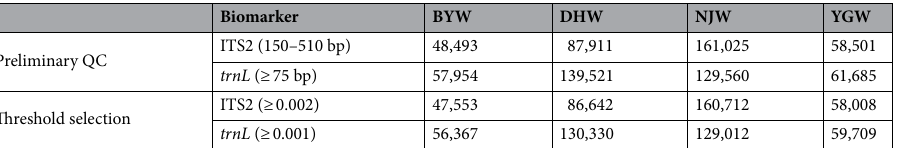
Table 1. The average number of reads of each sample after preliminary quality control and threshold filtration for the four TCM preparations. Note that, QC means quality control, we removed the reads that were below 150 bp or over 510 bp for ITS2, and the reads less than 75 bp for trnL , or the sequences that had an average quality score < 20 in each 5 bp-window rolling along with the whole read. Then we filtered out the species whose relative abundance was less than 0.002 for ITS2 and 0.001 for trnL.